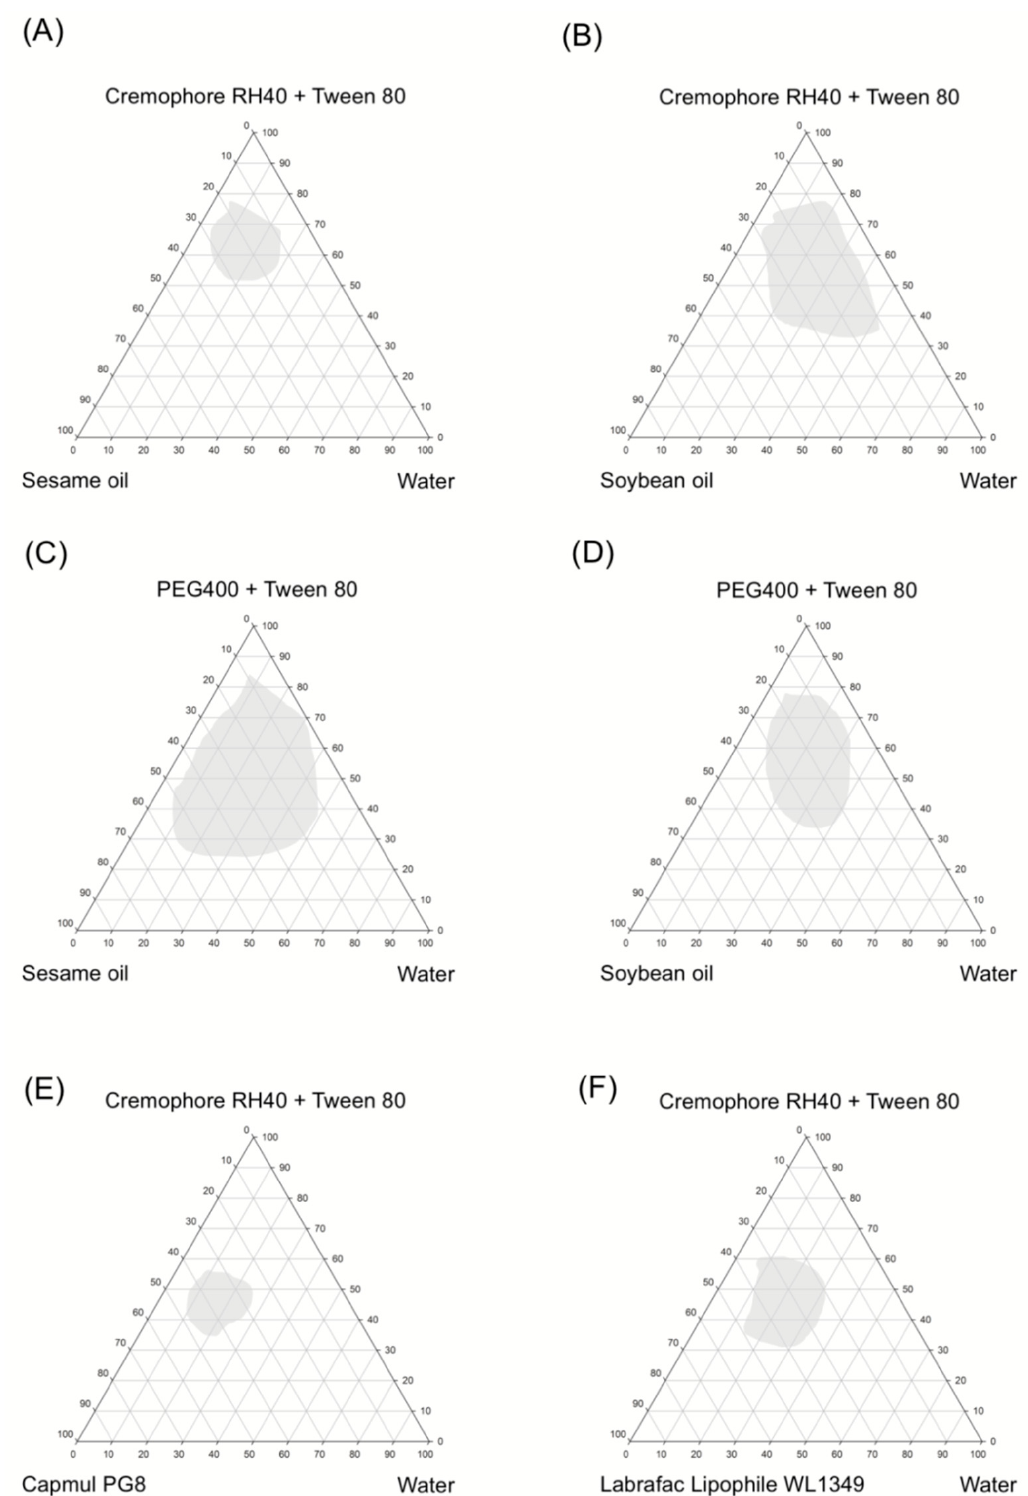
Figure 3. Pseudo-ternary phase diagram of various surfactant, co-surfactant, oil, and water. Microemulsion Figure 3. Pseudo ‐ ternary phase diagram of various surfactant, co ‐ surfactant, oil, and water. regions of the ternary plot are indicated in the gray Microemulsion regions of the ternary plot are indicated in the gray areas.